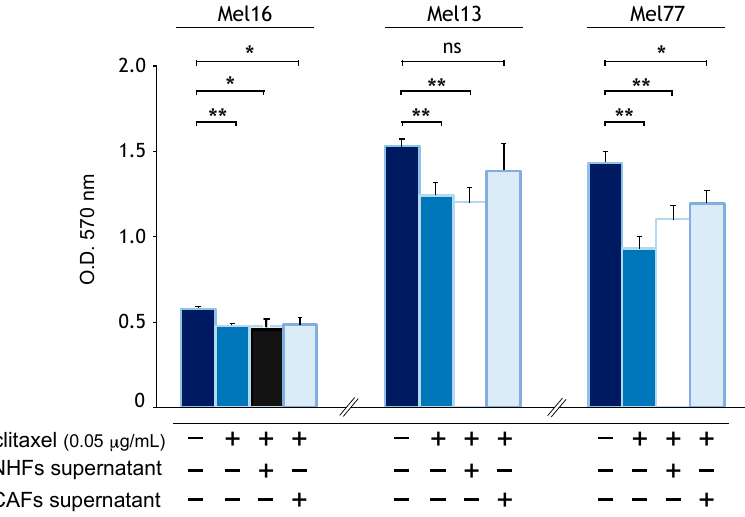
Figure 3. Effects of CAF supernatant on chemotherapy-induced cytotoxicity. MTT assay of melanoma cells treated with paclitaxel (0.05 µg/mL) in the presence or absence of NHF and CAF supernatant. Histograms show mean ± SD of three independent experiments performed with three different melanoma cell lines (Mel13, Mel77, and Mel16) treated with n = 3, n = 4, and n = 4 NHF supernatants, respectively, or with n = 4, n = 5, and n = 5 CAF supernatants, respectively. * p < 0.05 and ** p < 0.01 vs. control untreated cells. ns: not significant.